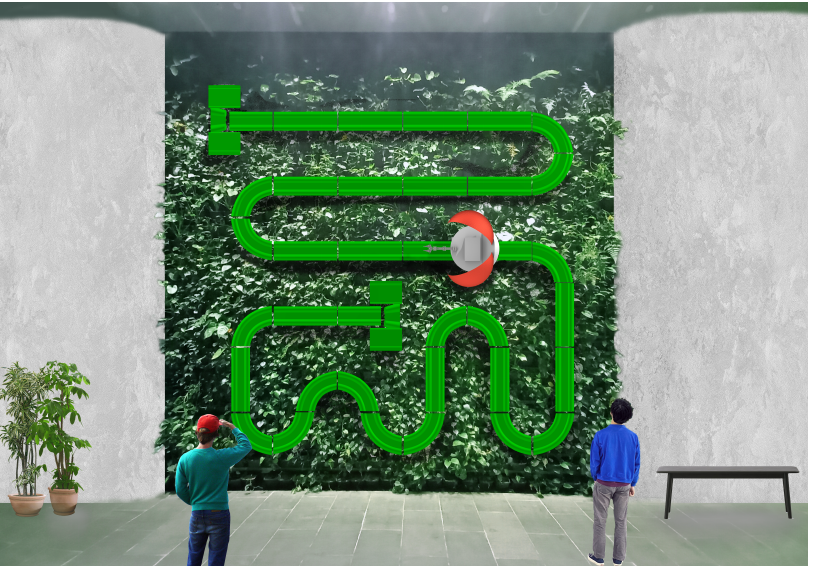
Figure 14. Artist’s impression of implemented